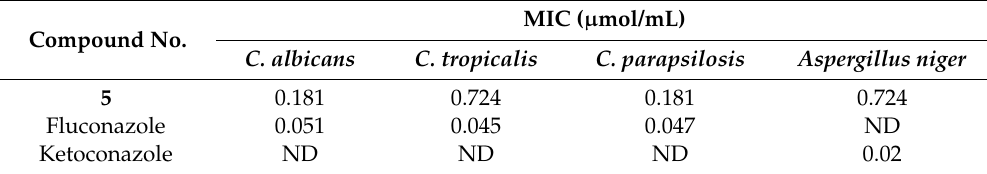
Table 5. The minimum inhibitory concentrations (MICs) values of the antifungal activity of the target compound 5 , fluconazole and ketoconazole against different Candida species and Aspergillus niger . Compound No.